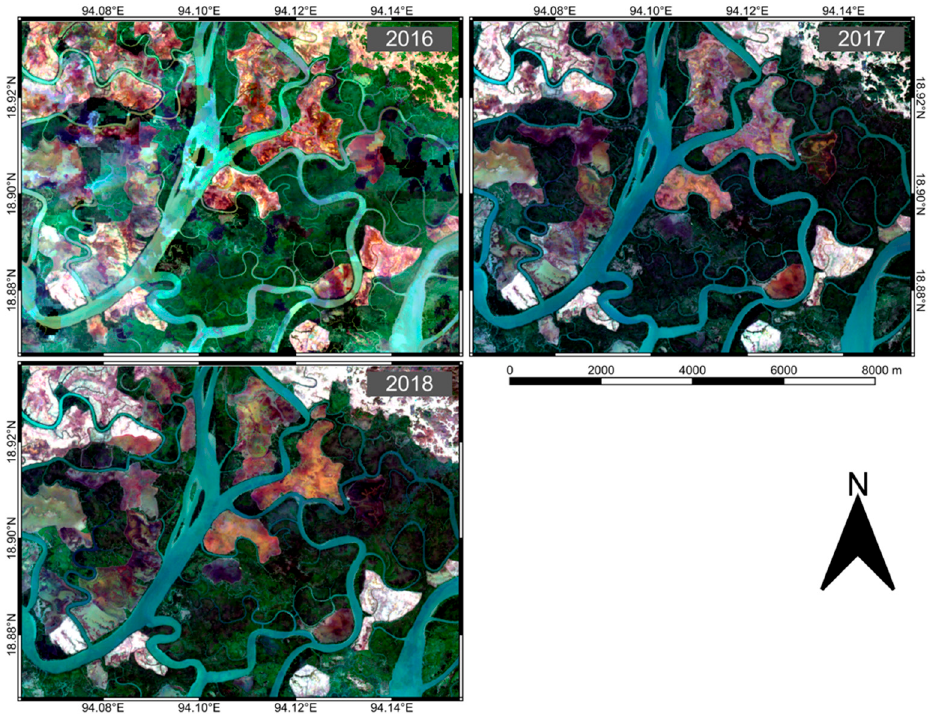
Figure 6. Median RGB images of the target area in 2016, 2017, and 2018. The images were captured by Sentinel-2. Only images with less than 30% cloud cover were selected, and remaining clouds were masked. The scalebar and north arrow apply to all images. Table 6. Confusion matrices with relative user and producer accuracies produced using U-Net for the 2016 classified image. Table 7. Confusion matrices with relative user and producer accuracies produced using U-Net for the 2017 classified image.